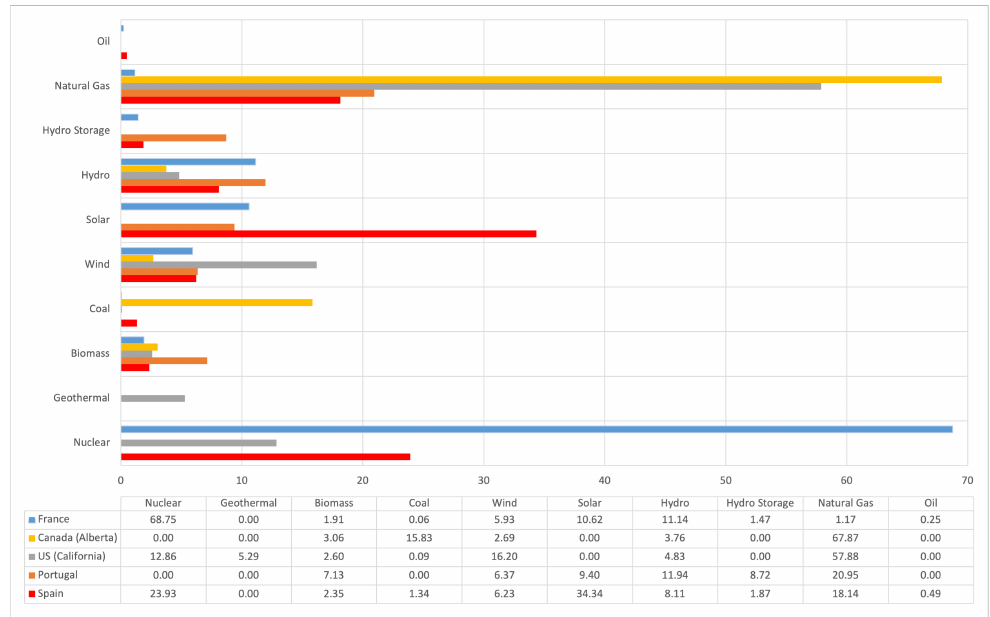
Figure 11. Energy sources for France, Portugal, Spain, California, and Alberta (25 July